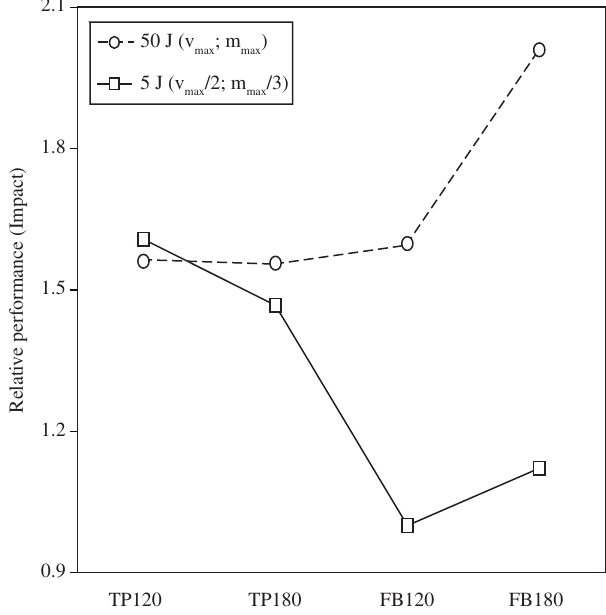
Figure 5. Relative impact performance (based on mean results of Table 3) of the carbon-epoxy laminates, for two different testing conditions. Point-to-point fits indicate the general trend of data